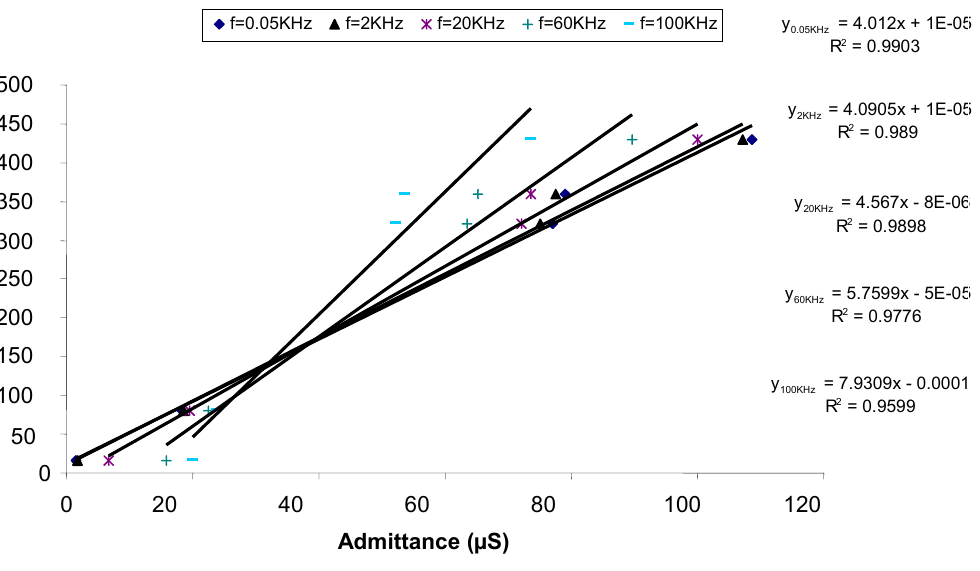
The Influence of electrodes setup